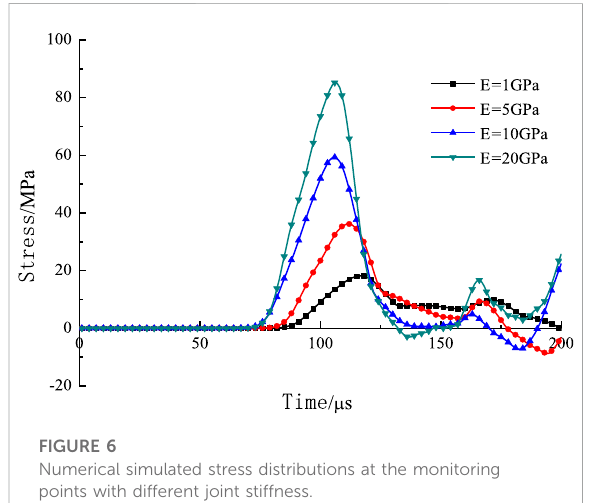
FIGURE 6 Numerical simulated stress distributions at the monitoring points with different joint stiffness.